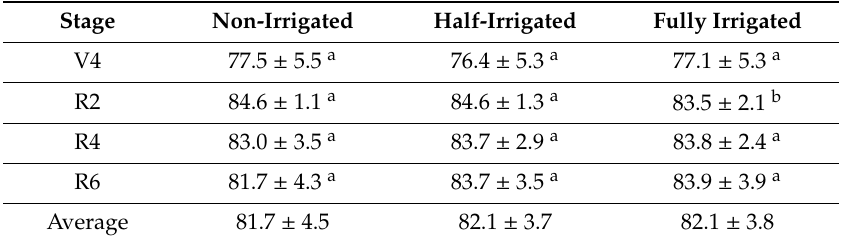
Table 6. The e ff ect of di ff erent irrigation regimes on NDVI at di ff erent stages of soybean’s (cv. Pannonia Kincse) life cycle, averaged among 2017, 2018, and 2019 in Debrecen, Hungary.